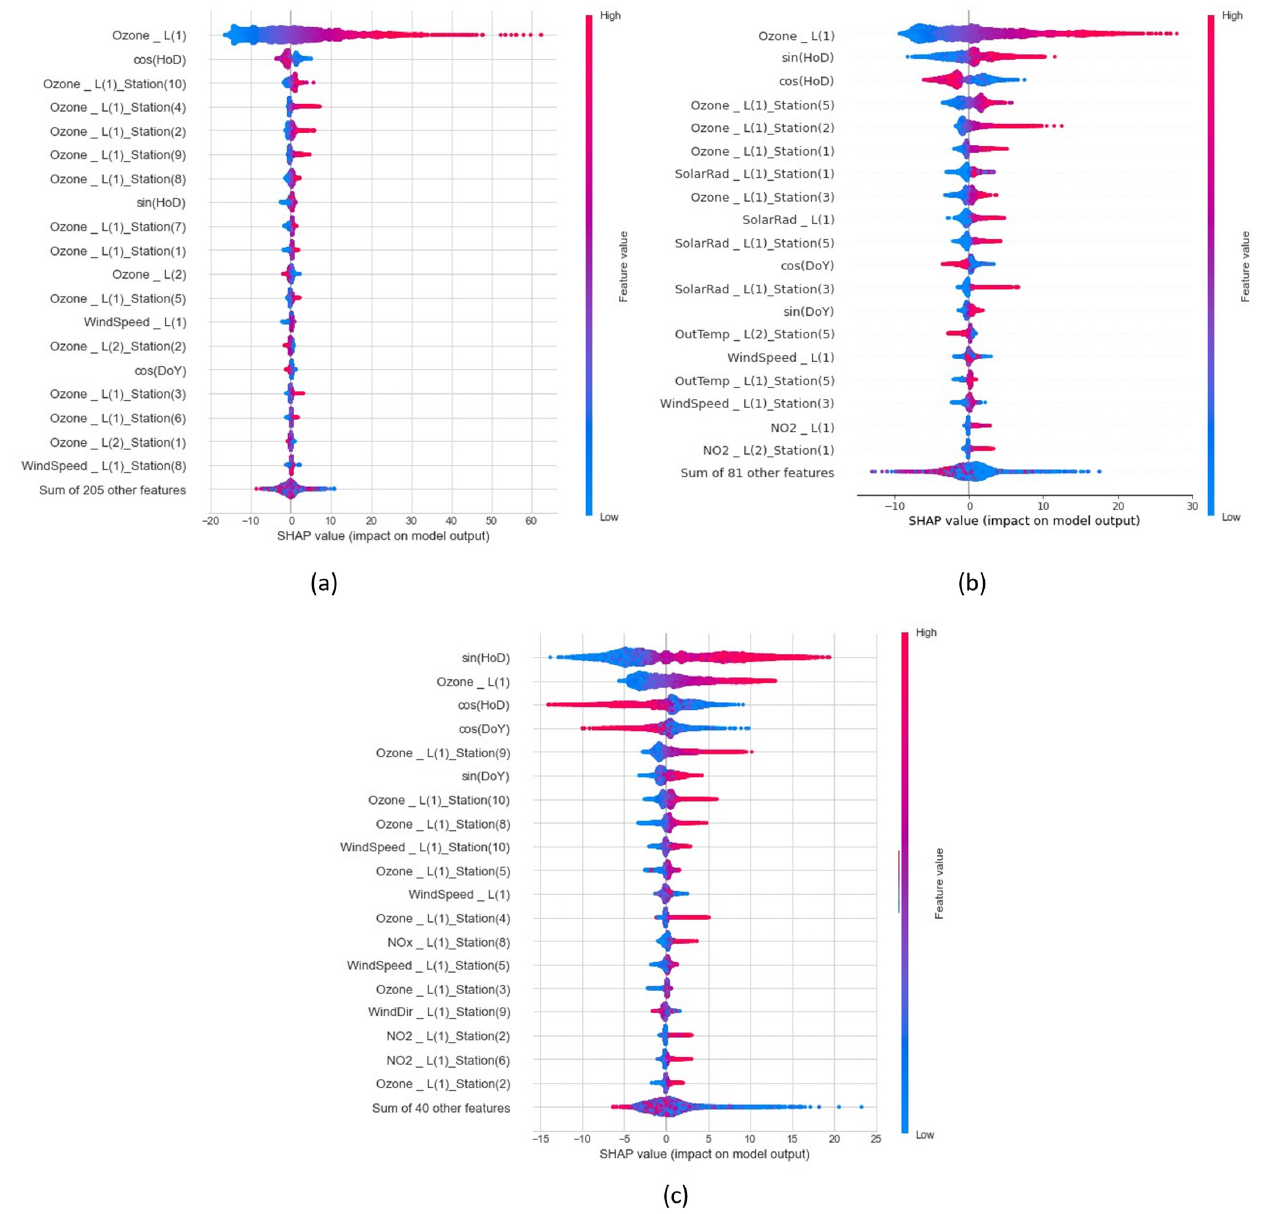
Figure 15. Influence of different attributes for 1 h ( a ), 3 h ( b ) and 6 h ( c ) forecasting horizons.